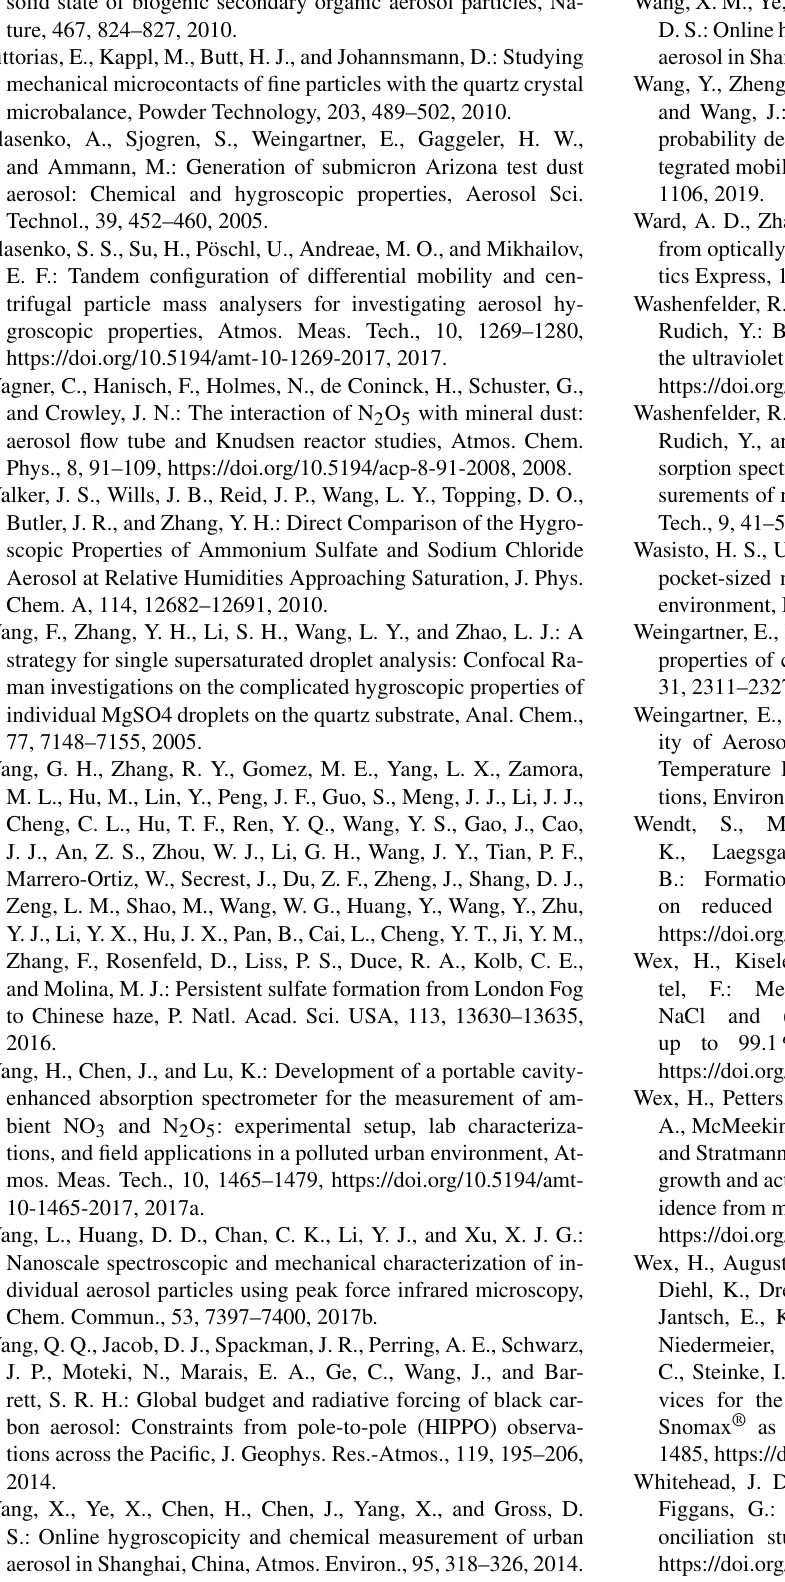
Figgans, G.: A meta-analysis of particle water uptake